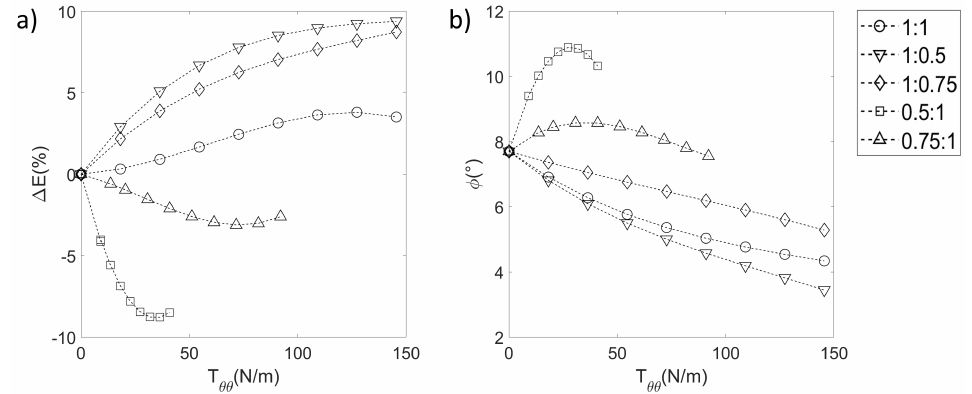
Figure 10. Microstructural curves resulting from the test case in terms of SALS eccentricity change ( a ) and preferential angle ( b